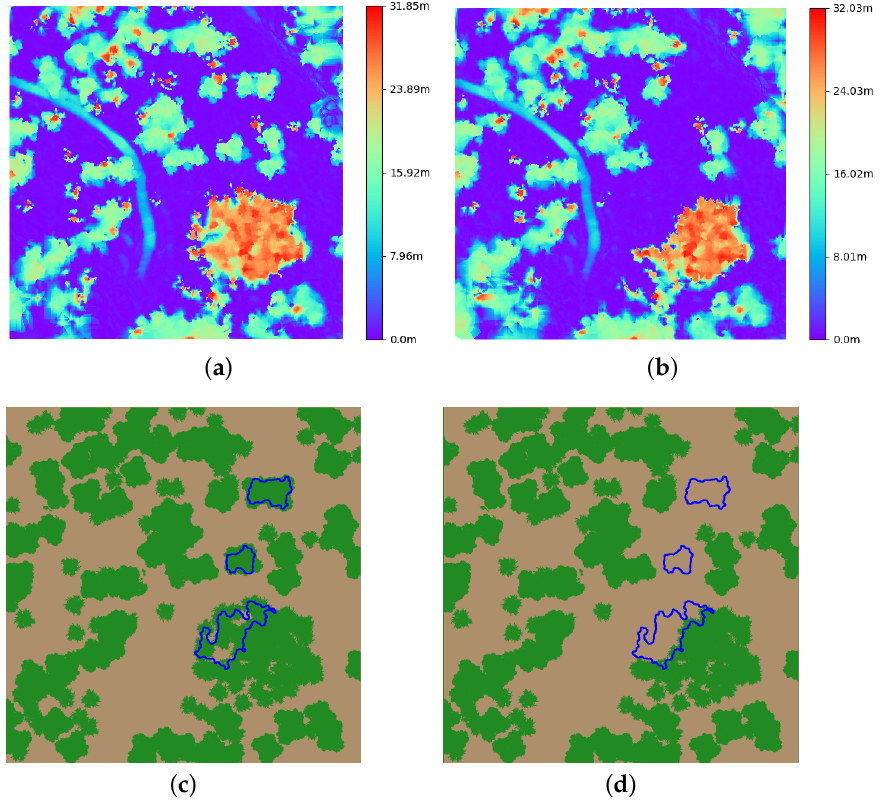
Figure 19. Change detection process for Yosemite . ( a ) CHM with trees. ( b ) CHM without trees. ( c ) Scenario with trees. ( d ) Scenario without